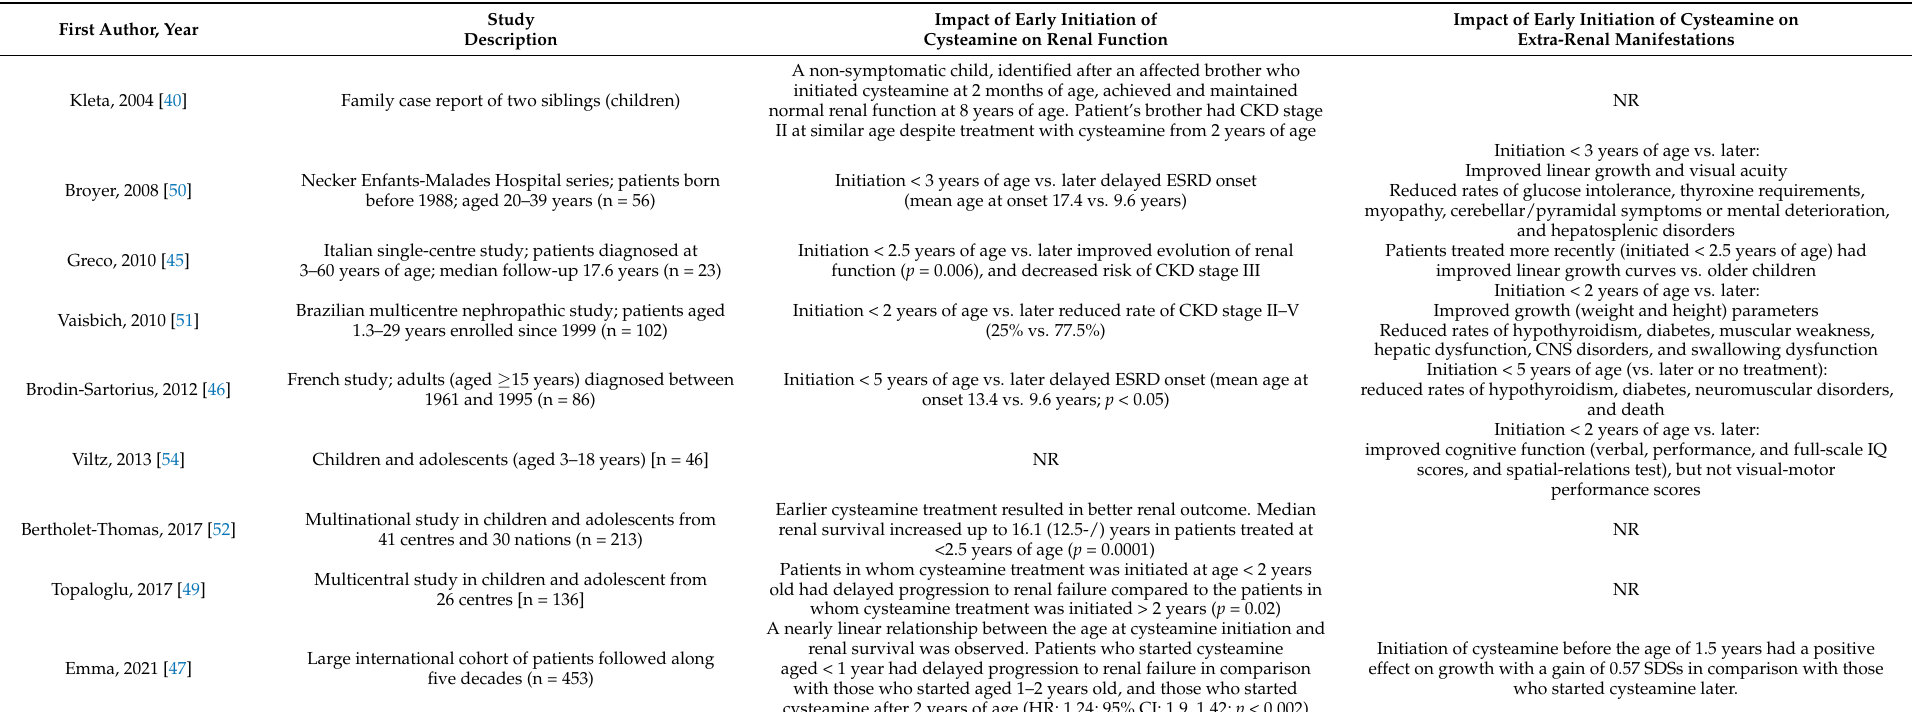
Table 2. Impact of early initiation of oral